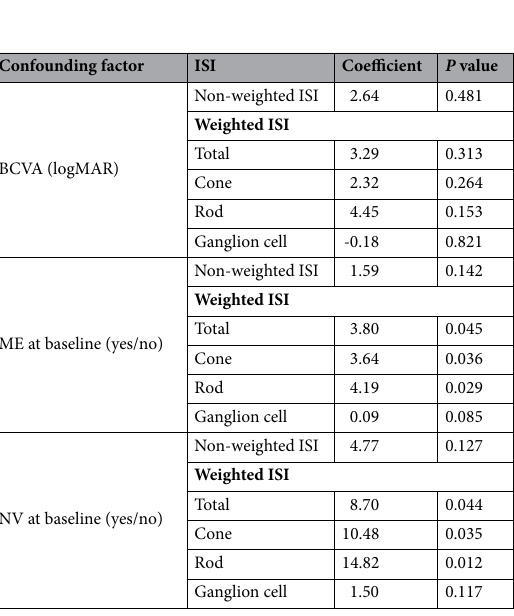
Table 3. Associations of baseline characteristics with weighted and non-weighted ISI of nonperfusion with leakage. P-values were calculated using multiple linear regression analysis. * P <